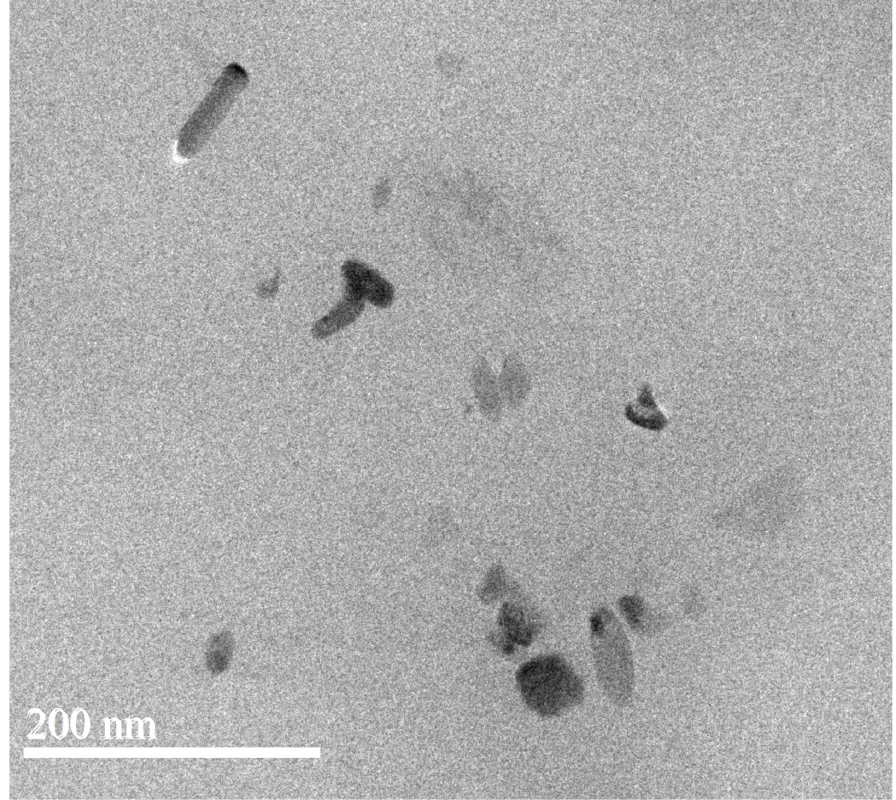
Figure 4. TEM images of the 5 wt% g-PBCT/m-PPZn